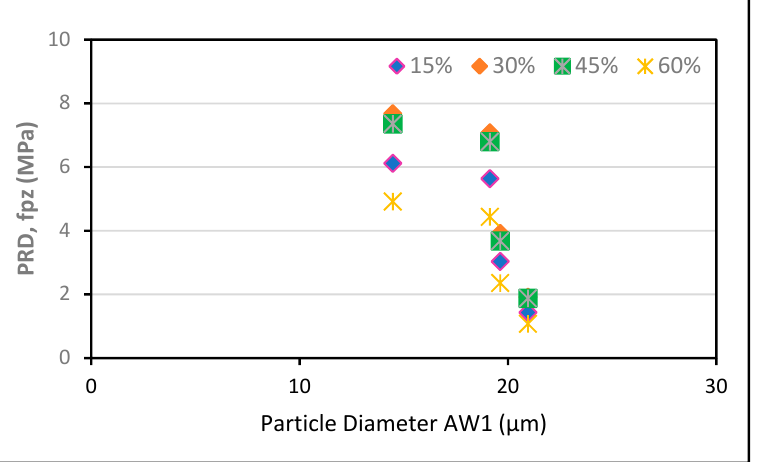
Figure 7. Discrepancy trends of pozzolanic involvement of RHA with different percentages at varying particle diameters.